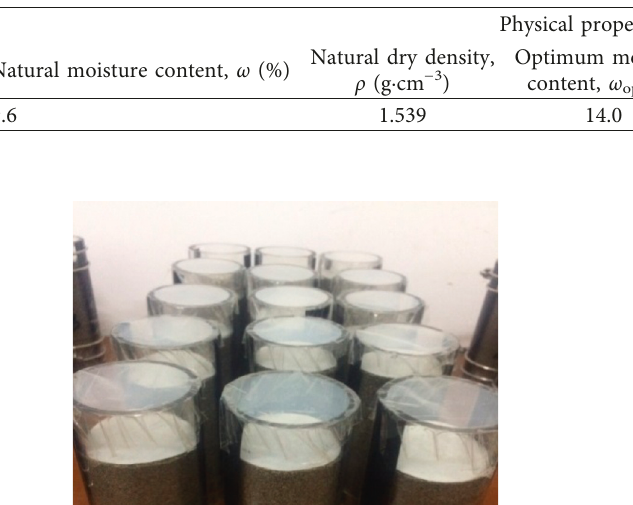
Table 2: Main physical property indexes of tailings.